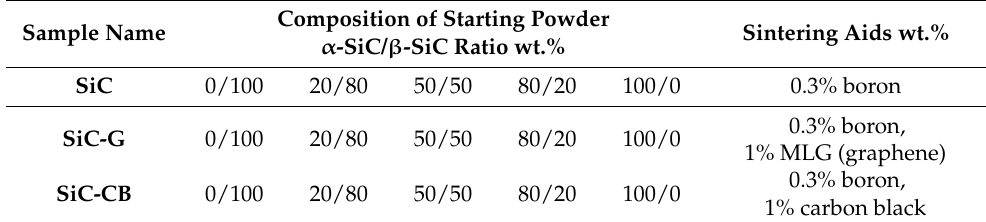
Table 1. Weight fractions of the prepared powder mixtures with additives.